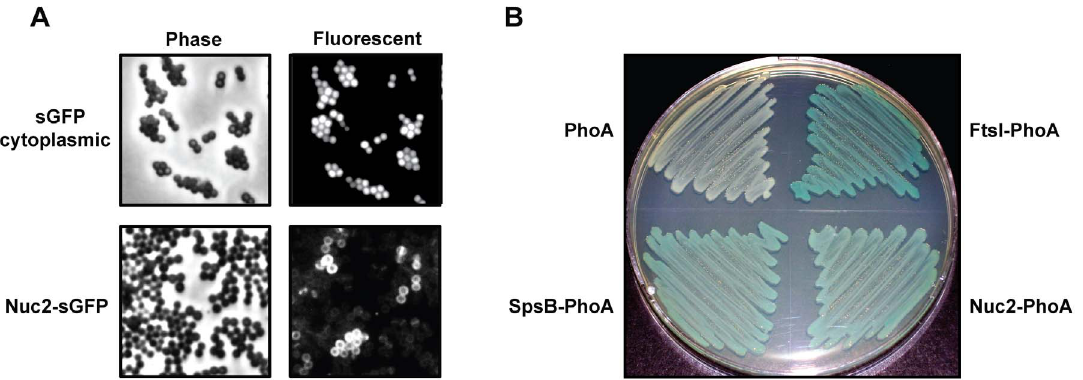
Figure 2. Localization and orientation of Nuc2 in the cell membrane. A . Phase and fluorescent microscopy of S. aureus expressing cytoplasmic sGFP or Nuc2-sGFP translational fusion. B . Alkaline phosphatase fusions grown in a PhoA dye indicator plate assay, where growth appearing white indicates PhoA is facing the cytoplasm and blue indicates PhoA is exposed to the periplasm. Shown clockwise from the upper left corner are: the E. coli phoA mutant host, an E. coli positive control protein fusion (FtsI-PhoA), the S. aureus Nuc2-PhoA protein fusion, and a S. aureus positive control protein fusion (SpsB-PhoA).